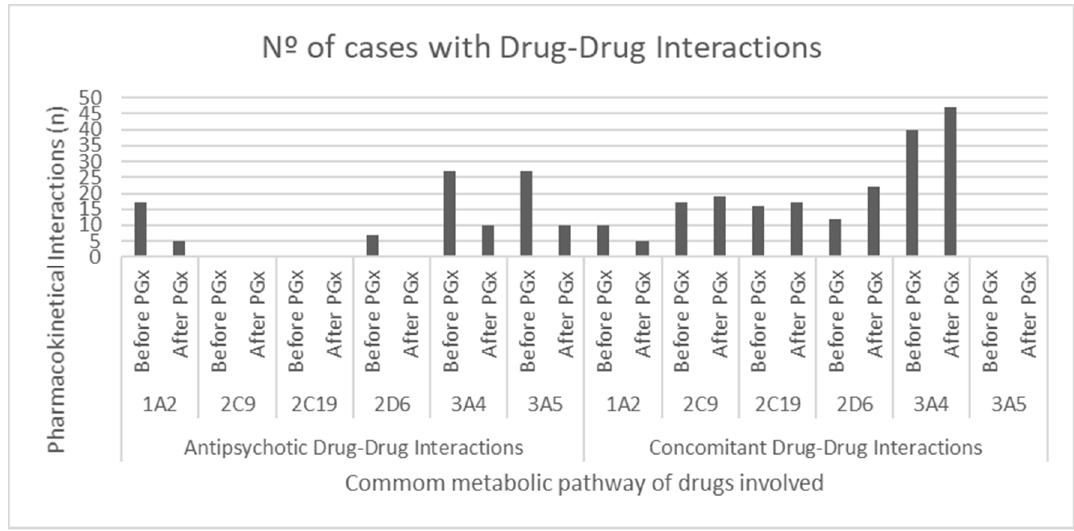
Figure 2. Number of conflicts found associated with each one of the Cytochrome P 450 (CYP450) members studied, before and after pharmacogenetic testing, including neuroleptic and concomitant therapy. PGx: Pharmacogenetic